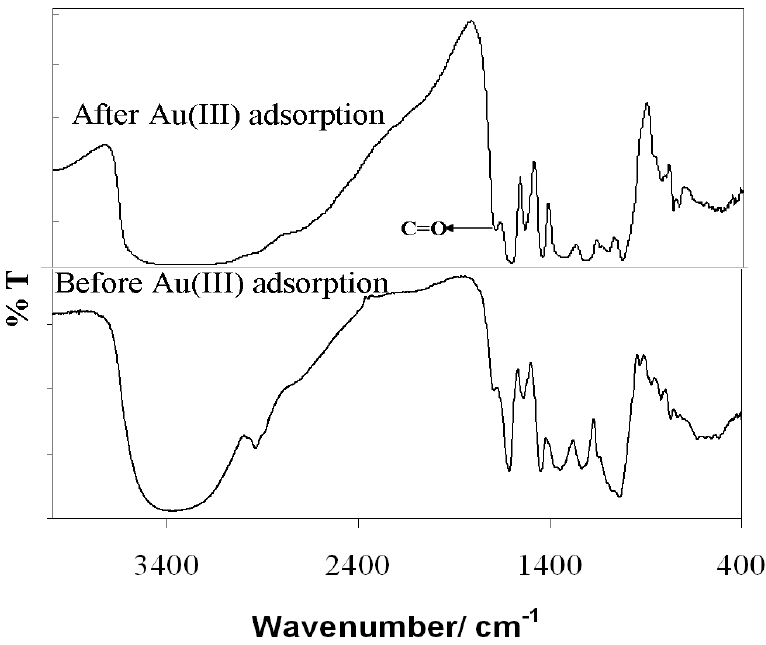
Figure 22. FT-IR spectra of crude PT powder before and after the adsorption of gold(III) [33] (with permission for reuse from Elsevier